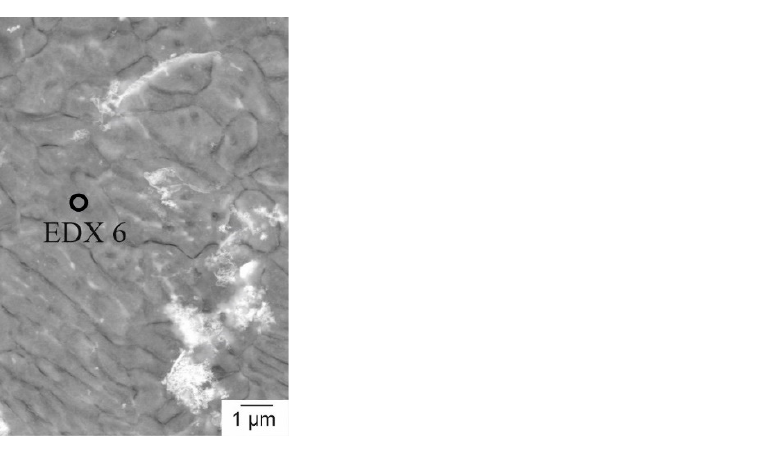
Figure 9. Backscattered electron images of PBF-LB-generated WE43 with the areas of the EDX measurements. Table 4. Composition of the EDX measurement of the spots in Figures 8 and 9.